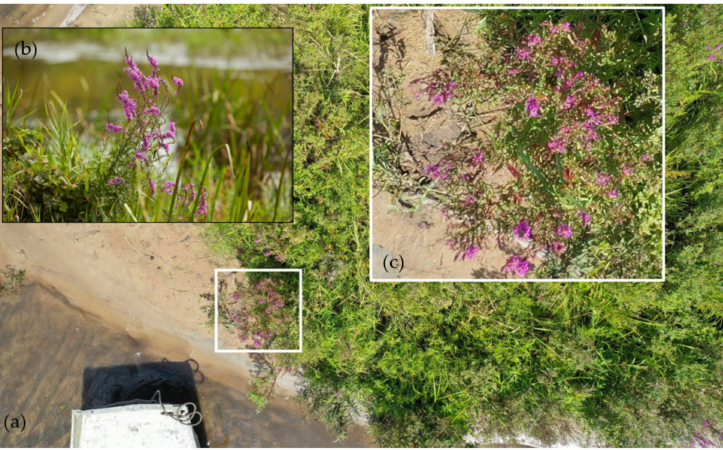
Figure 2. ( a ) Imagery taken at ~20 m height; ( b ) oblique view of a purple loosestrife plant; and ( c ) zoomed-in view of the loosestrife